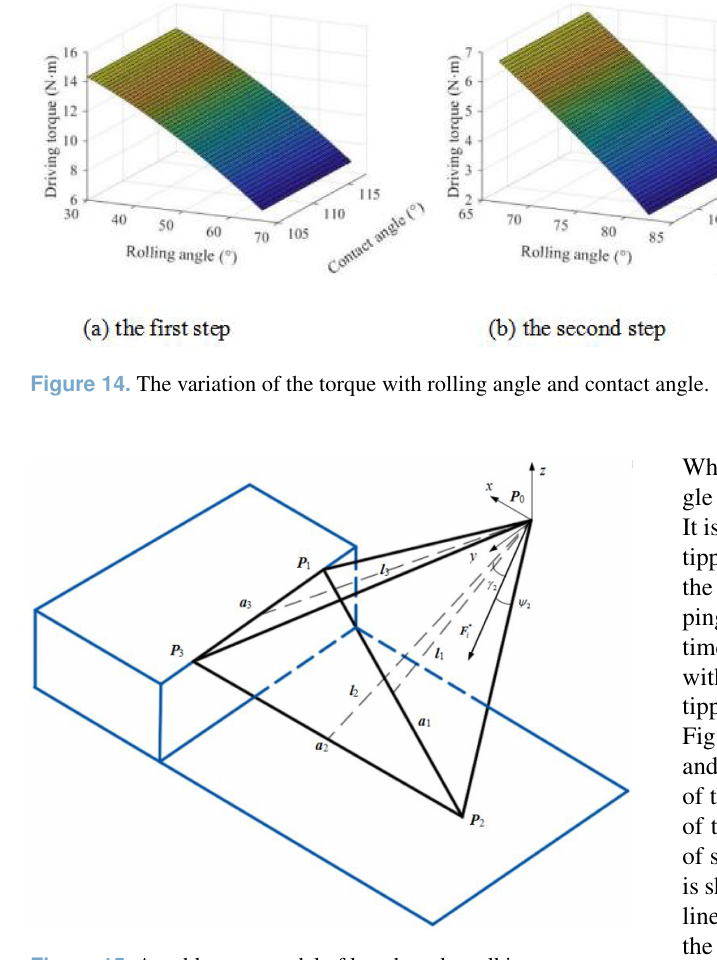
Figure 15. A stable cone model of leg obstacle